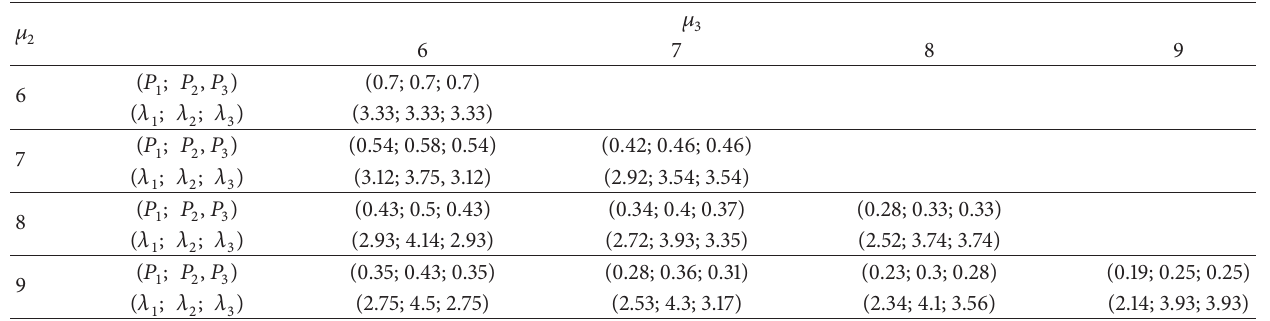
Table 8: The values (𝑃 1 ,𝑃 2 ,𝑃 3 ) and (𝜆 1 , 𝜆 2 , 𝜆 3 ) under 𝜆 = 10, 𝜇 1 =